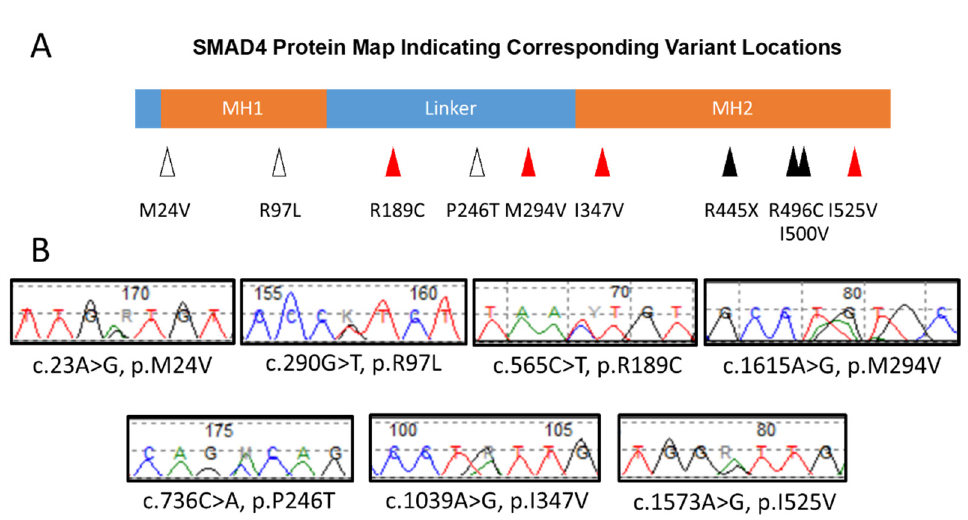
Figure 1. SMAD4 protein map and locations of the identified variants. ( A ) SMAD4 protein map indicating domains that harbor the identified variants; MH domains are indicated in orange. Arrows indicate the approximate location of variants identified by exon sequencing which were reported in Duan et al. 2019 (white), were novel (red), or identified as pathogenic or likely pathogenic variants in gnomAD v2.1.1 (black). ( B ) Representative Sanger sequencing results of seven variants that were identified by whole exome sequencing of TAA patient samples.